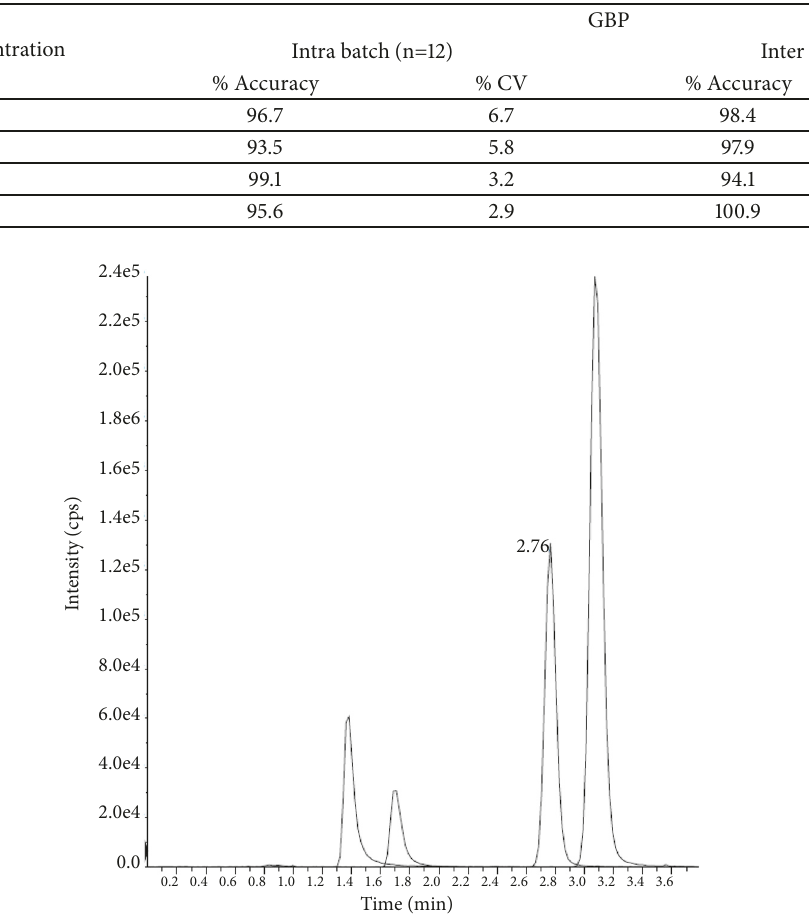
Table 3: Precision and accuracy results of GBP.